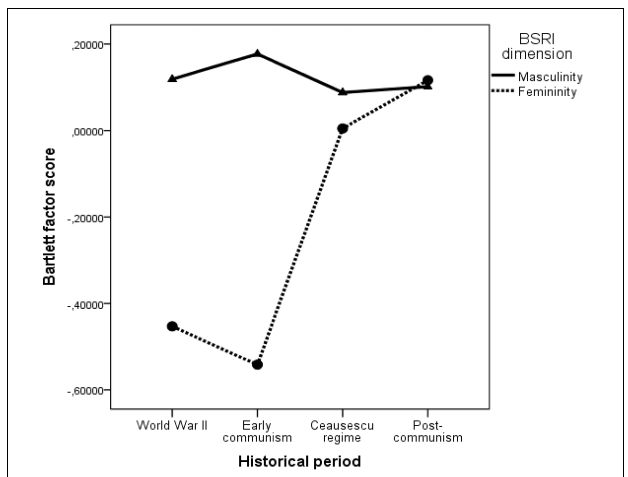
FIGURE 2 | Evolution of masculinity and femininity in time.